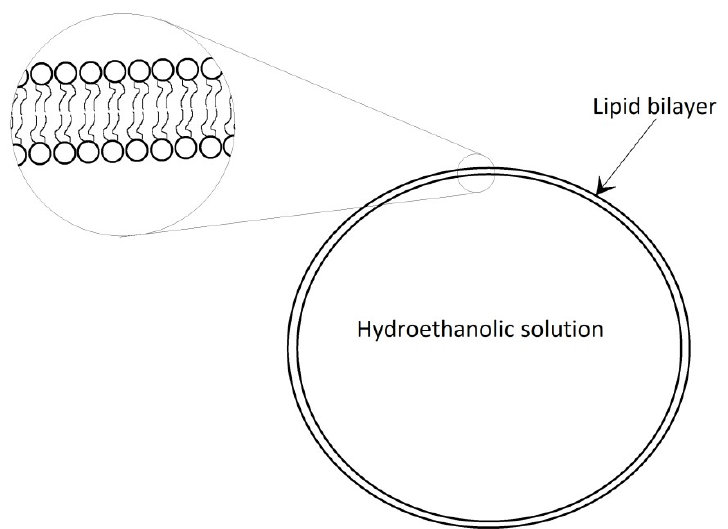
Figure 1. The structure of ethosomes.